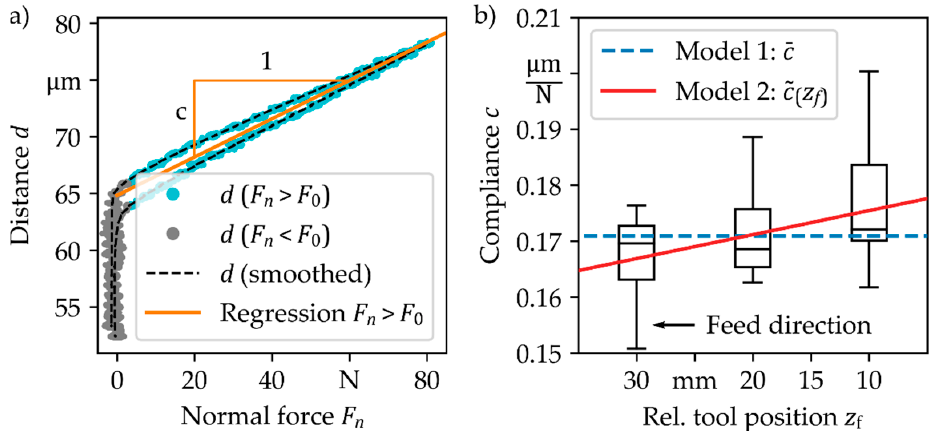
Figure 6. Evaluation of the effective machine compliances. ( a ) Exemplary measurement and compliance determination at relative tool position z f = 10 mm. (b) Overview of all resulting compliances c and comparison of the compliance models (1) and (2).